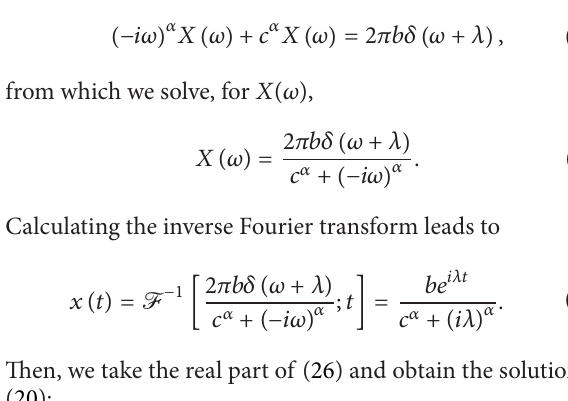
Figure 3: Curves of 𝑥(𝑡) versus 𝑡 for 𝑏 = 1, 𝑐 = 1, and 𝜆 = 1.5 and for 𝛼 = 1.2 (solid line), 𝛼 = 1.5 (dashed line), and 𝛼 = 1.8 (doted line).